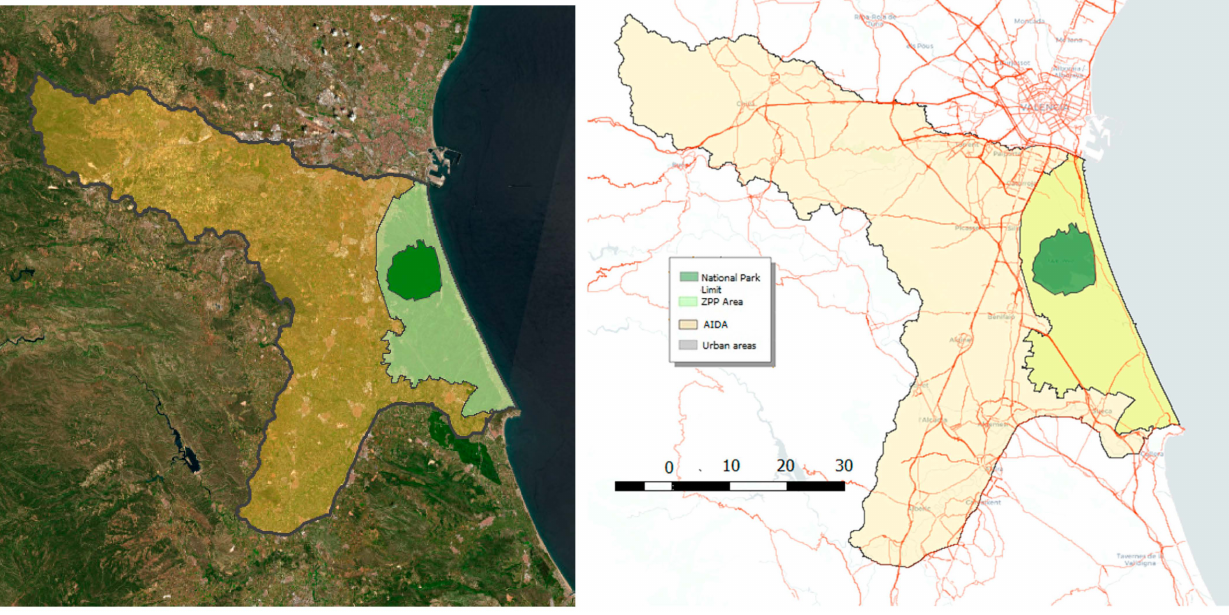
Figure 9. Area of influence of diffuse anthropization in the Albufera of Valencia Natural